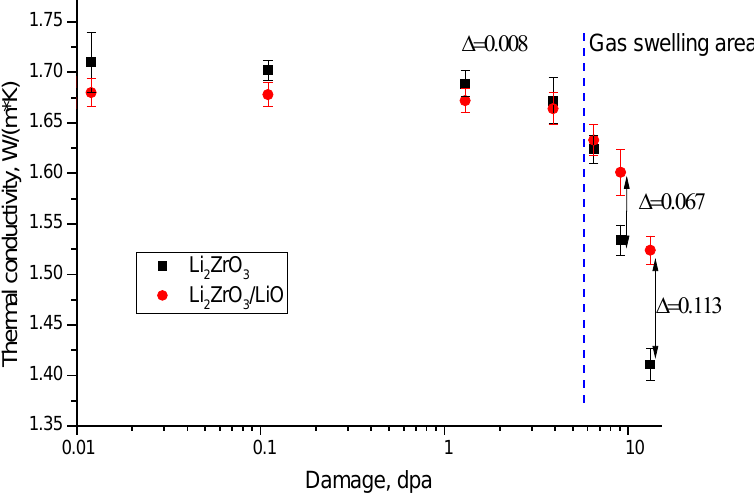
Figure 6. Results of changes in the thermal conductivity coefficient of ceramics depending on the irradiation dose (displacement values are presented on a logarithmic scale).